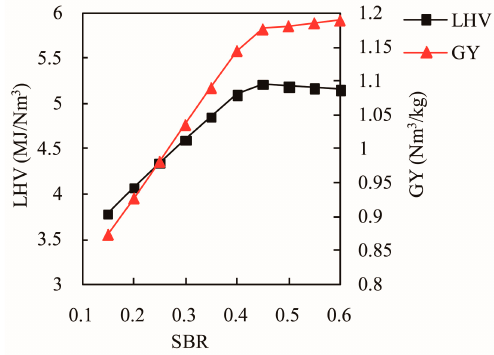
Figure 16. Effects of SBR on LHV and GY at T = 950 K and ER = 0.3.